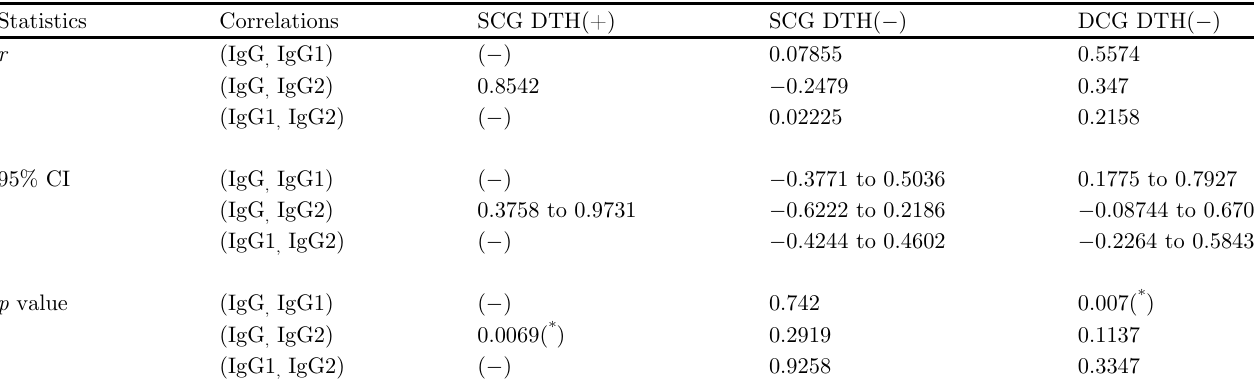
Table 2. Correlation analyses between IgG, IgG1, and IgG2 as a function of the variables of clinical state and DTH results.